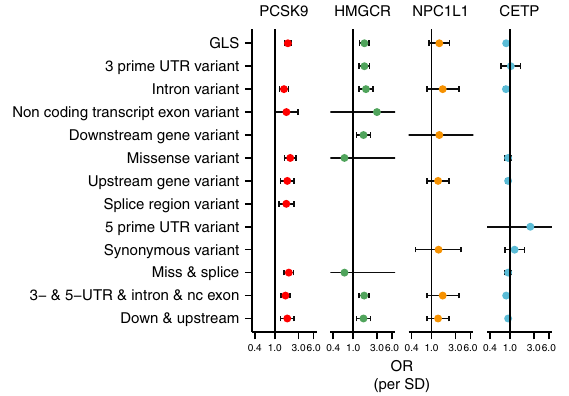
Fig. 4 Mendelian randomisation estimates of the lipids weighted associations with CHD strati fi ed by functionally of the included variants. Lipids data were used from the GLGC, and linked to coronary heart disease data from CardiogramPlusC4D. Pairwise LD remaining (after clumping on R-squared of 0.60) was accounted for using the 1000 genomes ‘ EUR ’ reference panel 52 and a (GLS) generalised least squares method 17 . Estimates for PCSK9, HMGCR , and NPC1L1 are given per SD in LDL-C, CETP estimates per HDL-C re fl ecting the likely effectiveness pathway to CHD. Estimates are given as OR with 95%CI (vertical error bars). Numerical details, including the number of variants used, are provided in Supplementary Tables 6 –